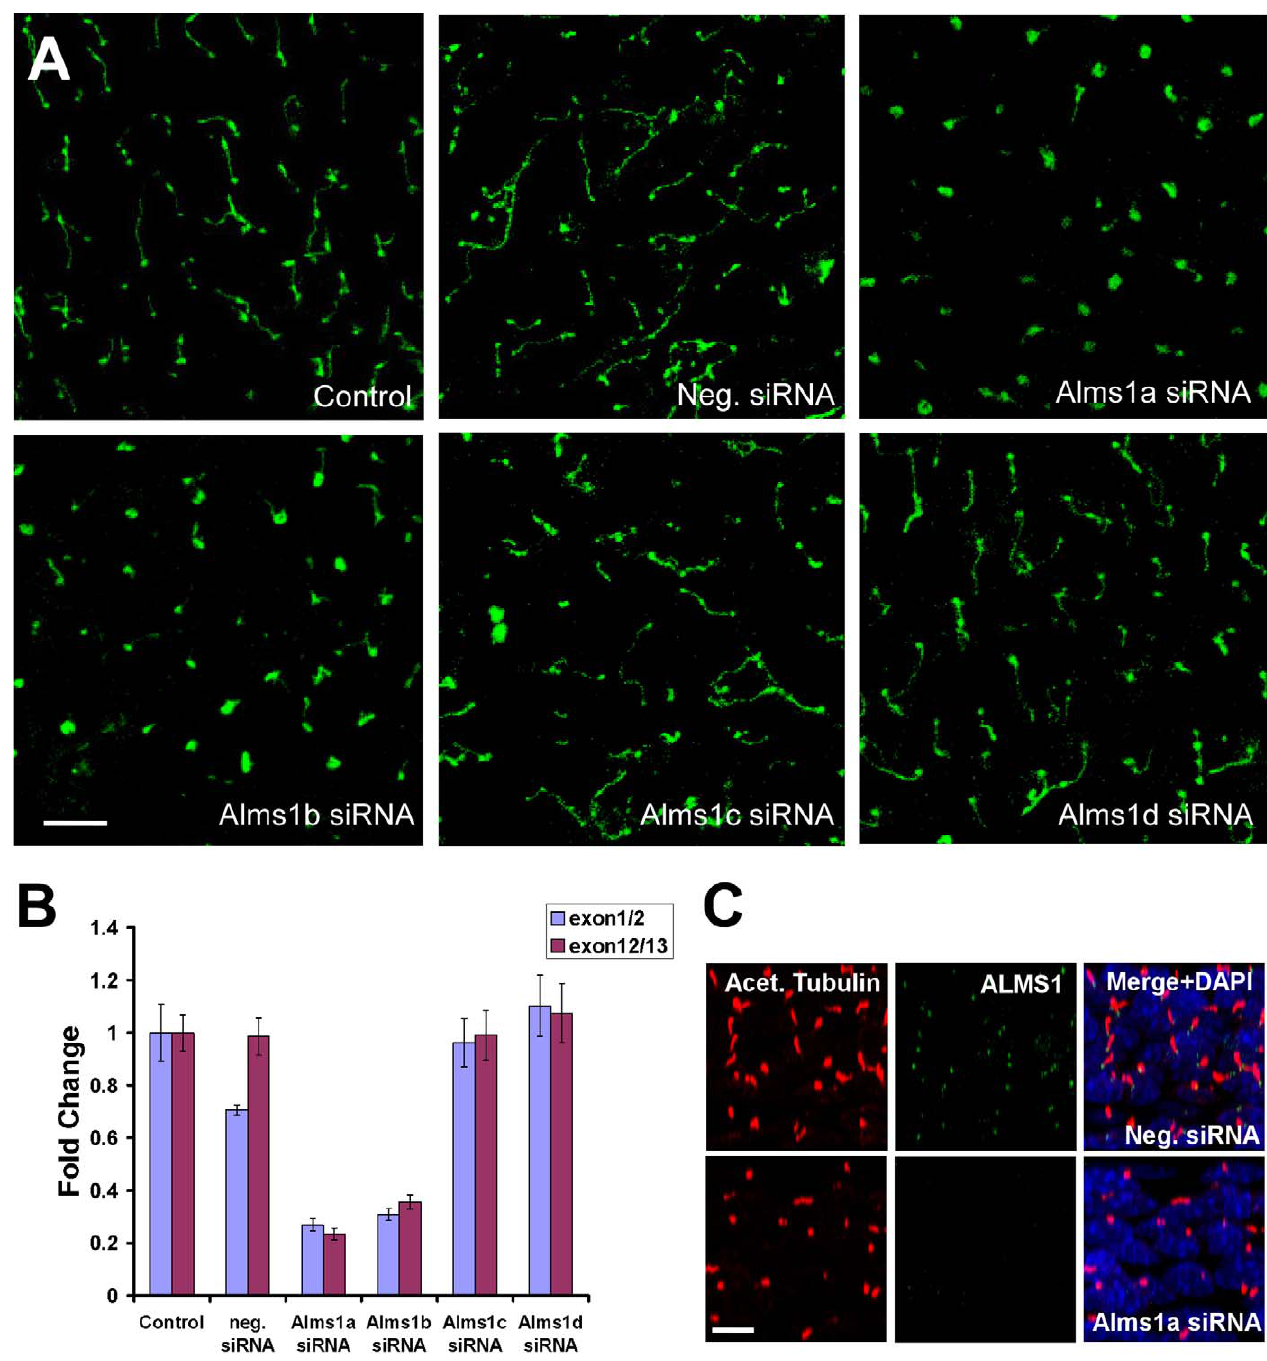
Figure 1. Suppression of Alms1 Expression Alters Primary Cilium Formation in Kidney Epithelial Cells (A) Elongated cilia, visualized with staining of acetylated tubulin (green), form normally in mIMCD3 cells after mock-transfection, transfection with a negative control siRNA, or transfection with two inactive siRNAs directed against Alms1 (Alms1c and Alms1d). Focal staining of acetylated tubulin without axoneme extension is seen after transfection with two active siRNAs targeting Alms1 (Alms1a and Alms1b). (B) Real-time PCR analysis with two mouse Alms1 probes recognizing the junctions of exons 1 and 2 and exons 12 and 13, respectively: Alms1a and Alms1b siRNAs both cause 70%–80% knockdown of Alms1 mRNA; no effect on Alms1 mRNA was seen with the three siRNAs that were inactive in the ciliogenesis assay. (C) Alms1a siRNA-treated cells lose endogenous Alms1 protein expression. Acet, acetylated. Scale bars, 10 l m.